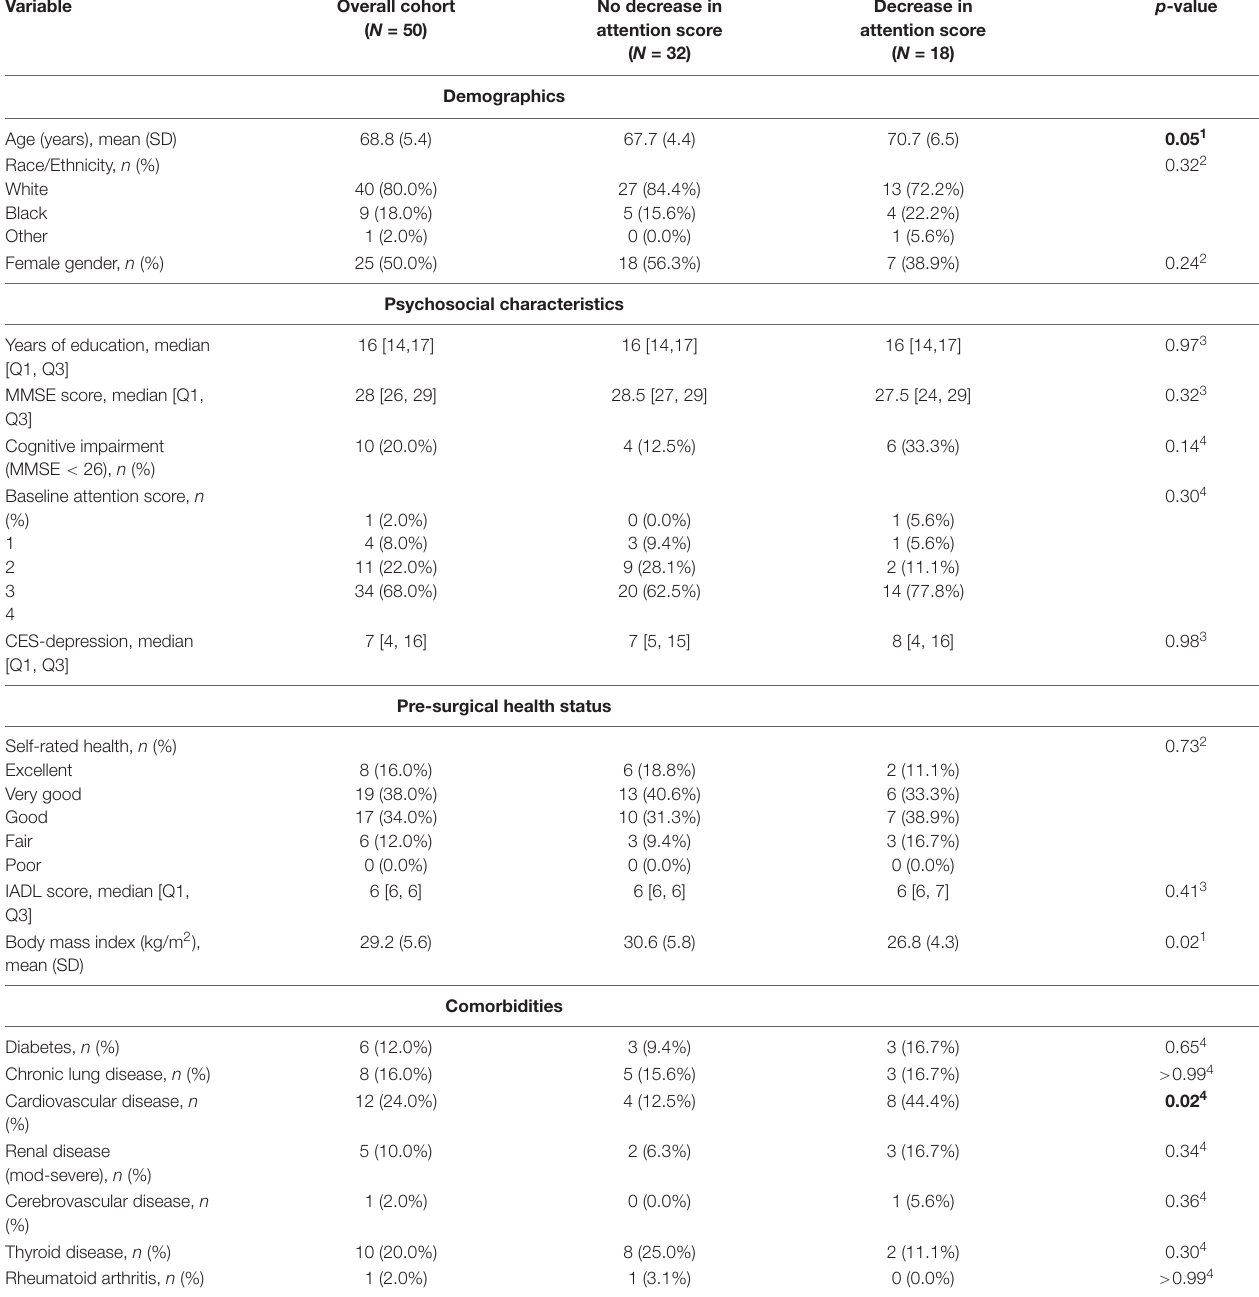
TABLE 1 | Pre-operative characteristics of all participants and a comparison of participants with and without a decrease in attention score on Day 1 after surgery. Variable Overall cohort ( N =